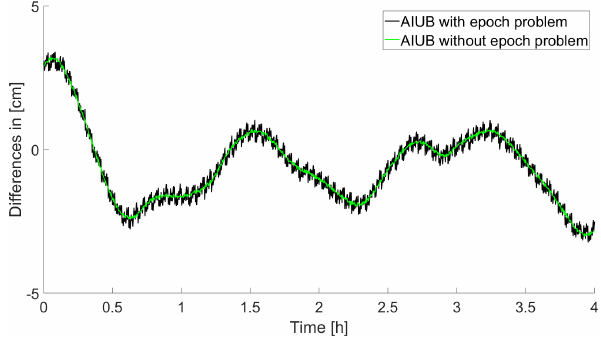
Figure 3. Comparison of different AIUB solutions versus CPOD solution in the along-track